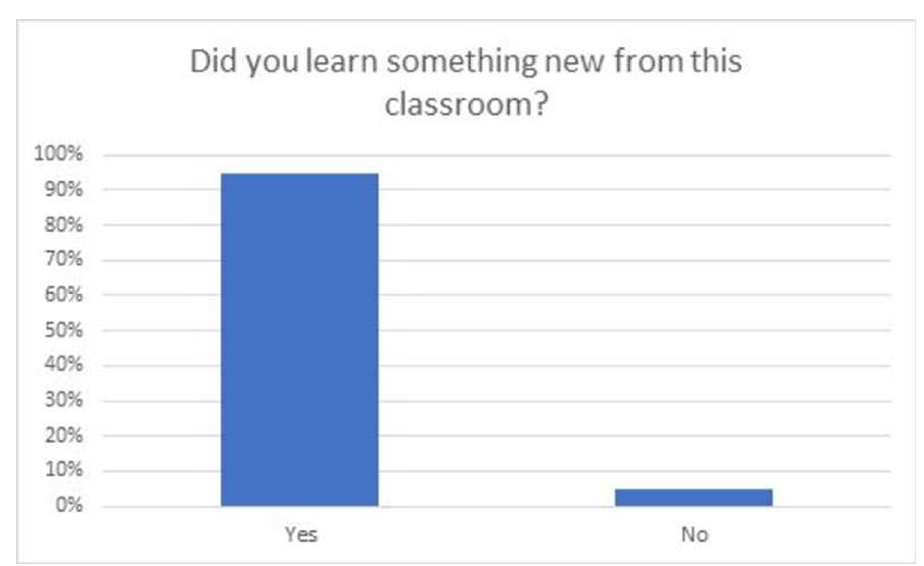
Fig 2. Survey responses if the class was successful in teaching something new to the students.